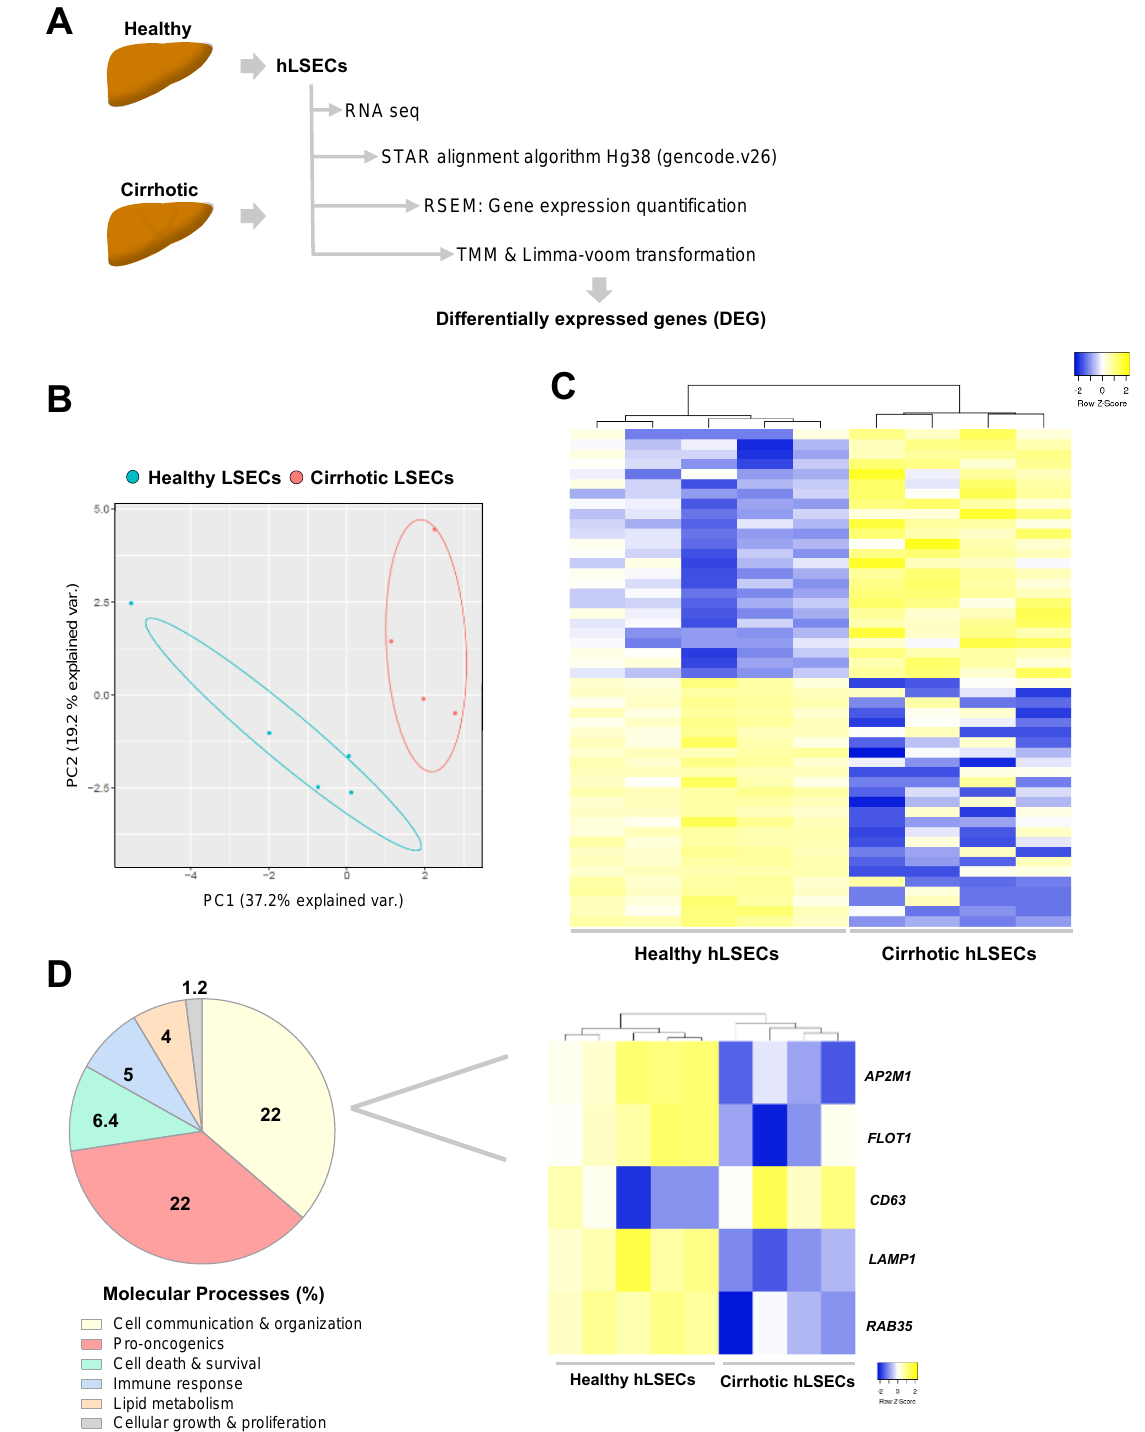
Figure 2. Transcriptomic profile of human LSECs in advanced CLD. (A) LSECs were isolated from human healthy and cirrhotic liver tissue, RNA was sequenced, and differential expression of genes was obtained as illustrated. (B) Principal Component Analysis of healthy and cirrhotic human LSECs transcriptomic profile. (C) Top 25 of up- (yellow) and down-regulated (blue) human cirrhotic LSECs genes depicted in heatmap. (D) Left, molecular processes deregulated in human cirrhotic LSECs analysed by Ingenuity Pathway Analysis. Right, heatmap of representative genes involved in extracellular vesicles biogenesis and secretion. n = 5 healthy LSECs and n = 4 cirrhotic LSECs. Significant differences are considered in RNAseq when fold-change > 1.5 and p -value < 0.05.